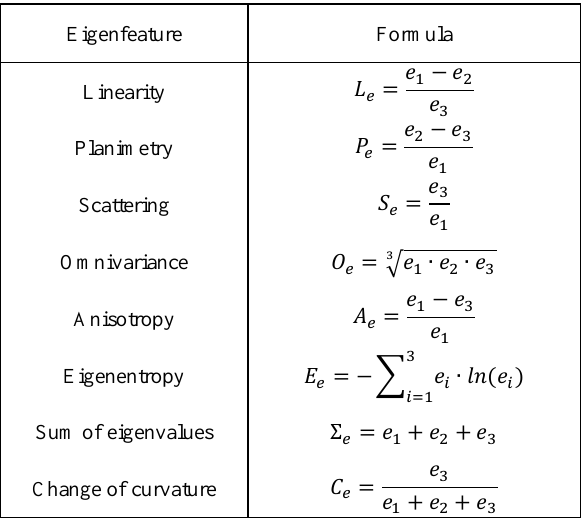
Table 1. Eigenfeatures mathematical